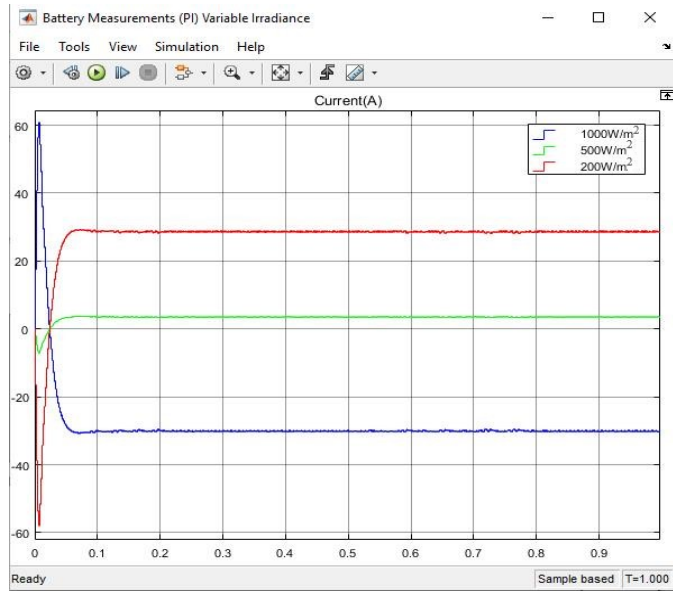
Figure 10. Battery current profile at three irradiance levels.